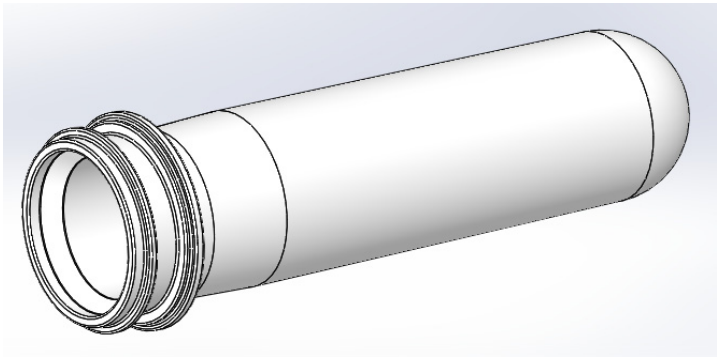
Figure 3. Three-dimensional CAD Model for 28 g preform . Table 1. Properties of the PET Generic Material used for 3D Model Simulation .